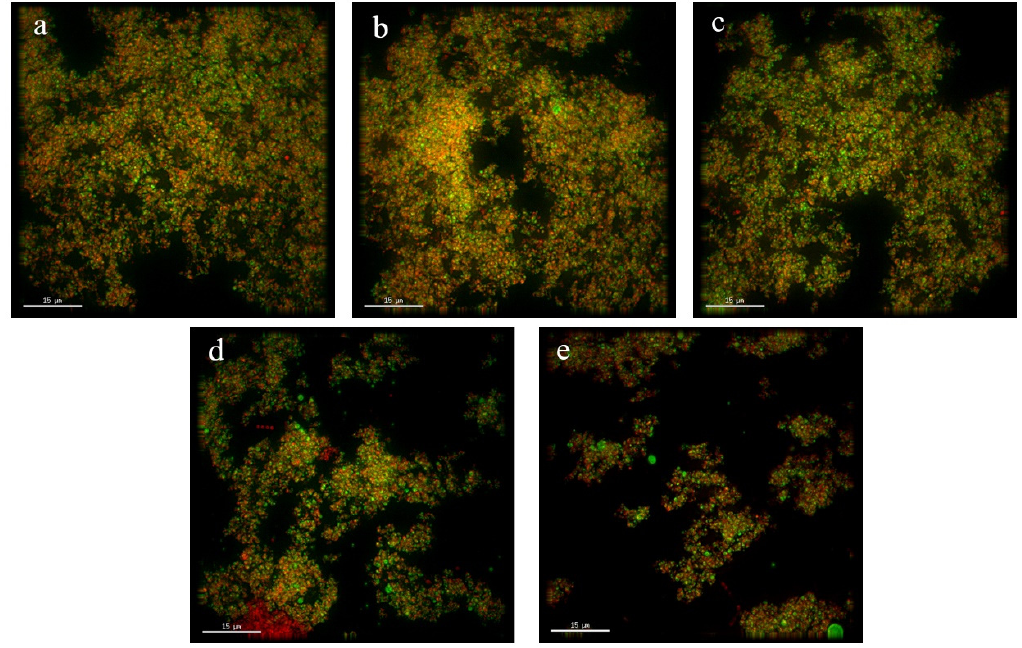
Figure 3. Microstructure of yogurt with different substitution amounts. Note: ( a – e ) are laser confocal micrographs of yogurt with 0% substitution, yogurt with 25% substitution, yogurt with 50% substitution, yogurt with 75% substitution and yogurt with 100% substitution, respectively.